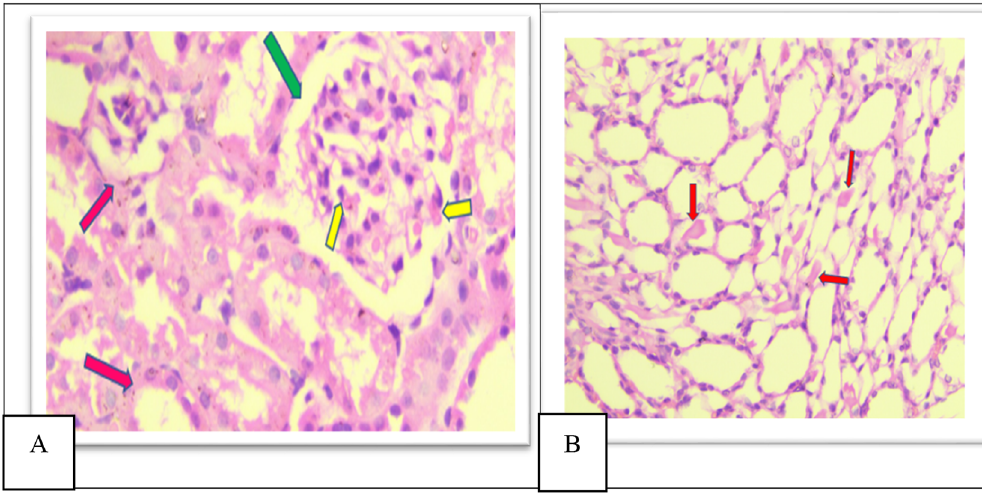
Figure 10. A. Section of the kidney tissue of rat (Group VI) Shows mild congestion of glomeruli (Yellow arrow) theinterstitial spaceshows mild congestionand degeneration (Pinkarrow) and mildincreased urinary space (Green arrow) (H&E, (cid:1) 40). B. Section of the kidney tissue of the rat (Group VI) Shows that a few casts (Red arrow) are seen within tubular lumens (H&E, (cid:1)